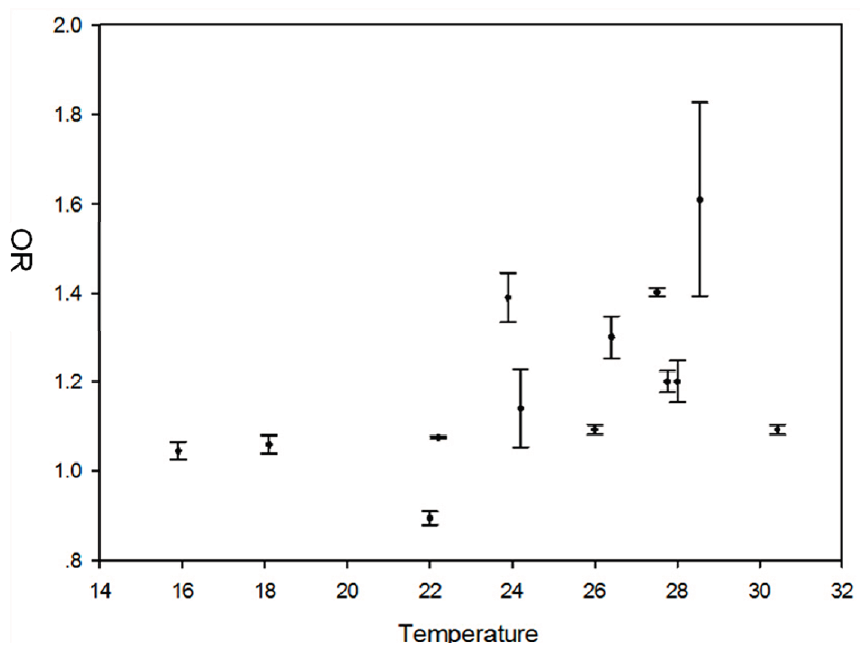
Figure 1. The scatter plot between extracted temperatures and OR of DF. Table 1. OR and 95% CI between T (Random-effects